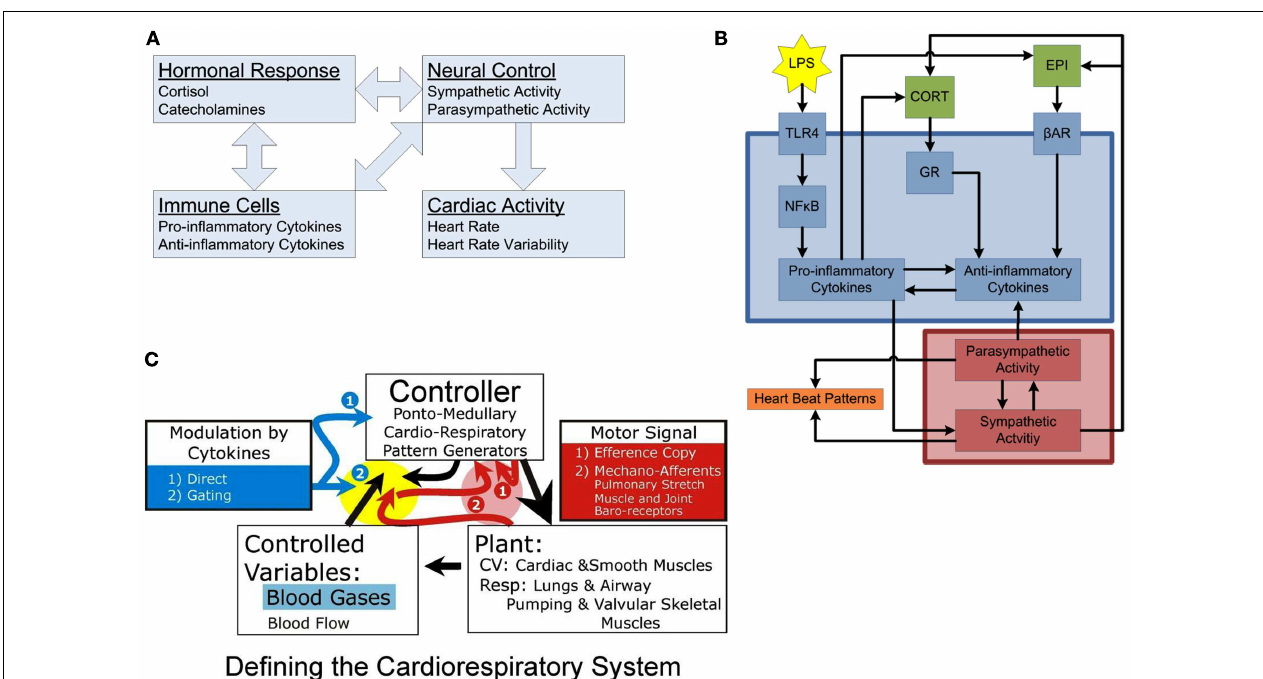
copy and (2) Mechano-receptors [pulmonary stretch, muscle- and joint-, and baro-receptors] which provide input to controller regarding plant performance on a breath-by-breath or beat-by-beat basis for a given motor signal (large black arrow).Yellow highlight: these arrows relate to how the controlled variables and the mechano-receptor afferents are modulated by the controller and in the presence of cytokines.The yellow and pink highlight areas relate to the nTS and dl pons, respectively. In the dl pons, we hypothesize that mechano-receptor afferent project to the dl pons (via the nTS) and interact with an Efference Copy produced by the controller. Efference Copy is defined as a copy of the motor signal delivered to the plant. Differences between these dl pontine inputs (e.g., the magnitude and strength of the muscle contraction, the lung inflation, etc) are compared to the generated motor signal. Loss of variability in the activity pattern of the plant can result from a failure of the controller to adapt to disparities between sensory input and Efference Copy. In the nTS, cytokines are expressed during ALI and, we expect sepsis, and may affect how afferent input is relayed to the controller. We propose a gating mechanism; one in which afferent inputs are depolarized and neural transmission efficacy is